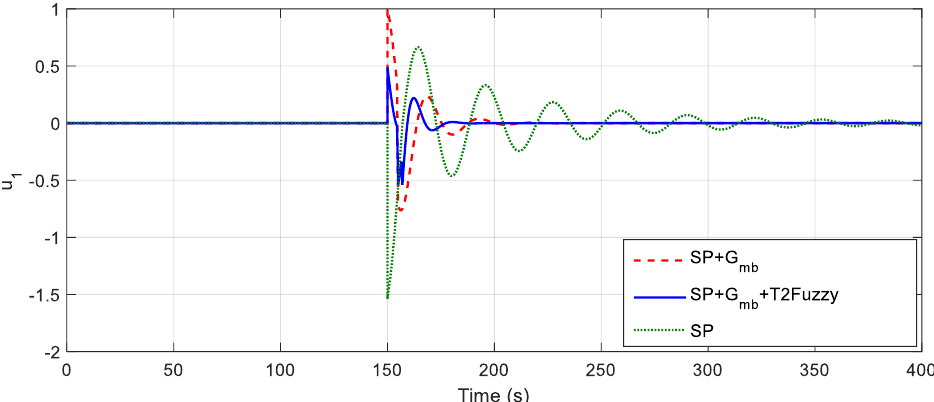
Figure 12. Performance of three control methods for 𝑦 2 by applying disturbance.